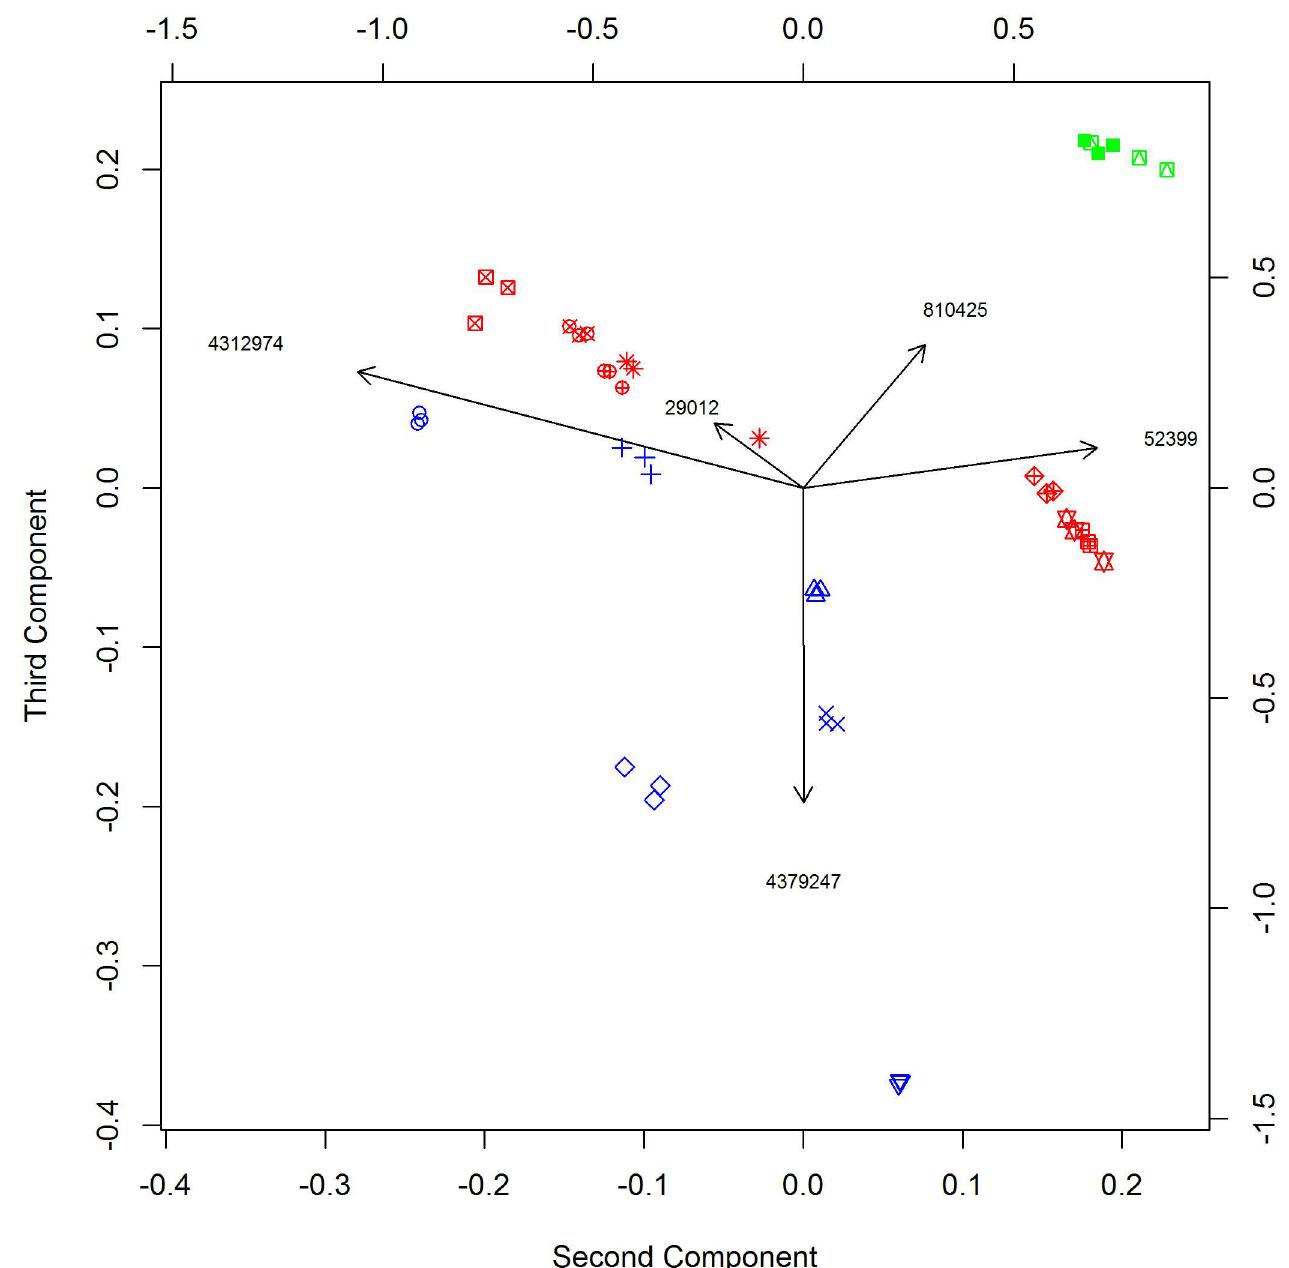
Fig 3. Biplot for second and third component of tobacco bacterial data. Points are colored by type (blue = dry, red = moist, green = toombak) and samples corresponding to replicates of the same product are plotted with the same symbol. The taxonomicfamilies correspondingto the OTUs shown are Staphylococcaceae (4312974), Aerococcaceae (52399), Lactobacillaceae (4379247), Enterococcaceae (29012)and Corynebacteriaceae (810425).The scale on bottom and left corresponds to coordinates of samples, scale on right and top to coordinatesof OTUs.